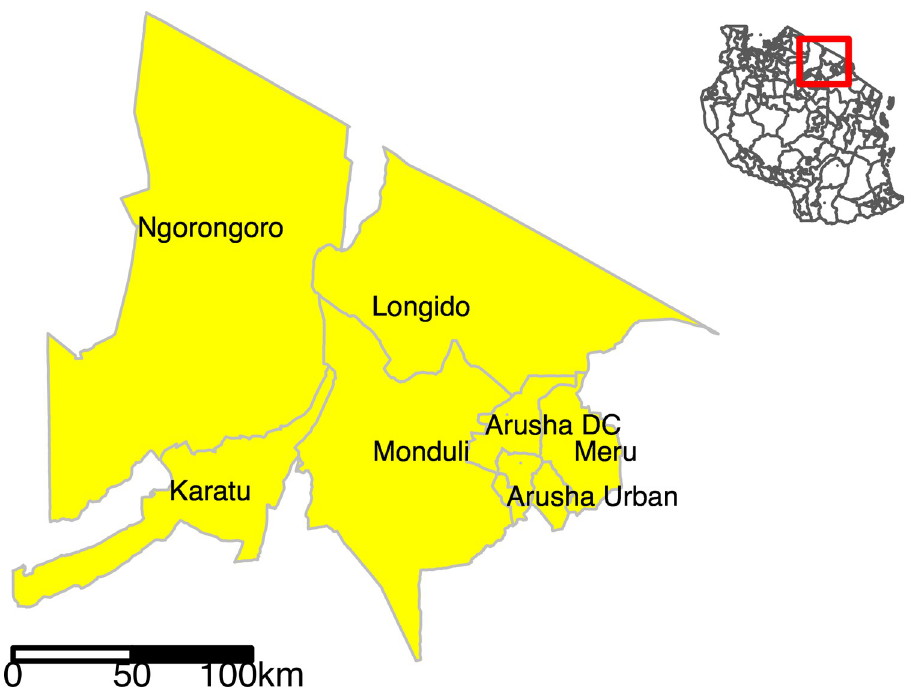
Fig 1. Map of Tanzania showing the seven administrative districts in Arusha Region (yellow shading) where the study was conducted. Yellow shaded polygons in the insert show Arusha districts within an outline map of Tanzania (no shading). Map created using R software version 3.6.3 and the tmap R package [38]. Shape files for administrative boundaries from the 2012 census were sourced from the Tanzania National Bureau of Statistics (https://www.nbs.go. tz/nbs/takwimu/references/Licence-Agreement-NBS.pdf)